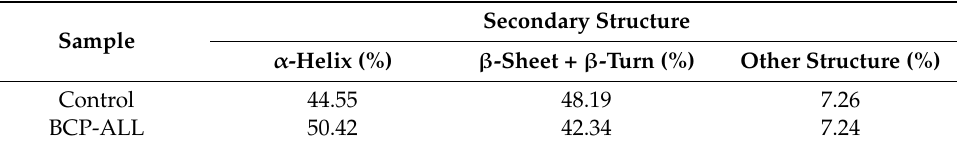
Table 2. The secondary structure composition (%) for the control and BCP-ALL average samples. They were calculated as the average of the sum of the individual values in each sample.